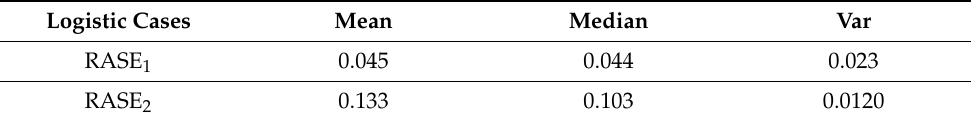
Table 15. The RASE criterion with the non-parametric function η ( . ) and slope function β ( . ) for the case n = 500.